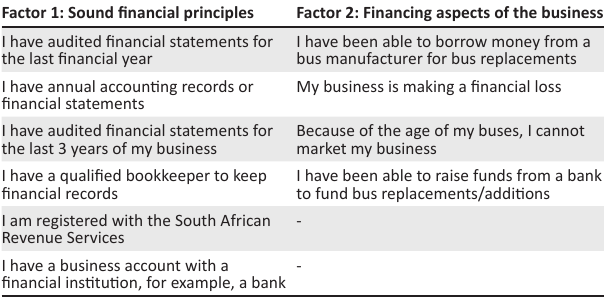
TABLE 4: Factor loadings after rotation: Financial aspects of the small-bus operators business. Factor 1: Sound financial